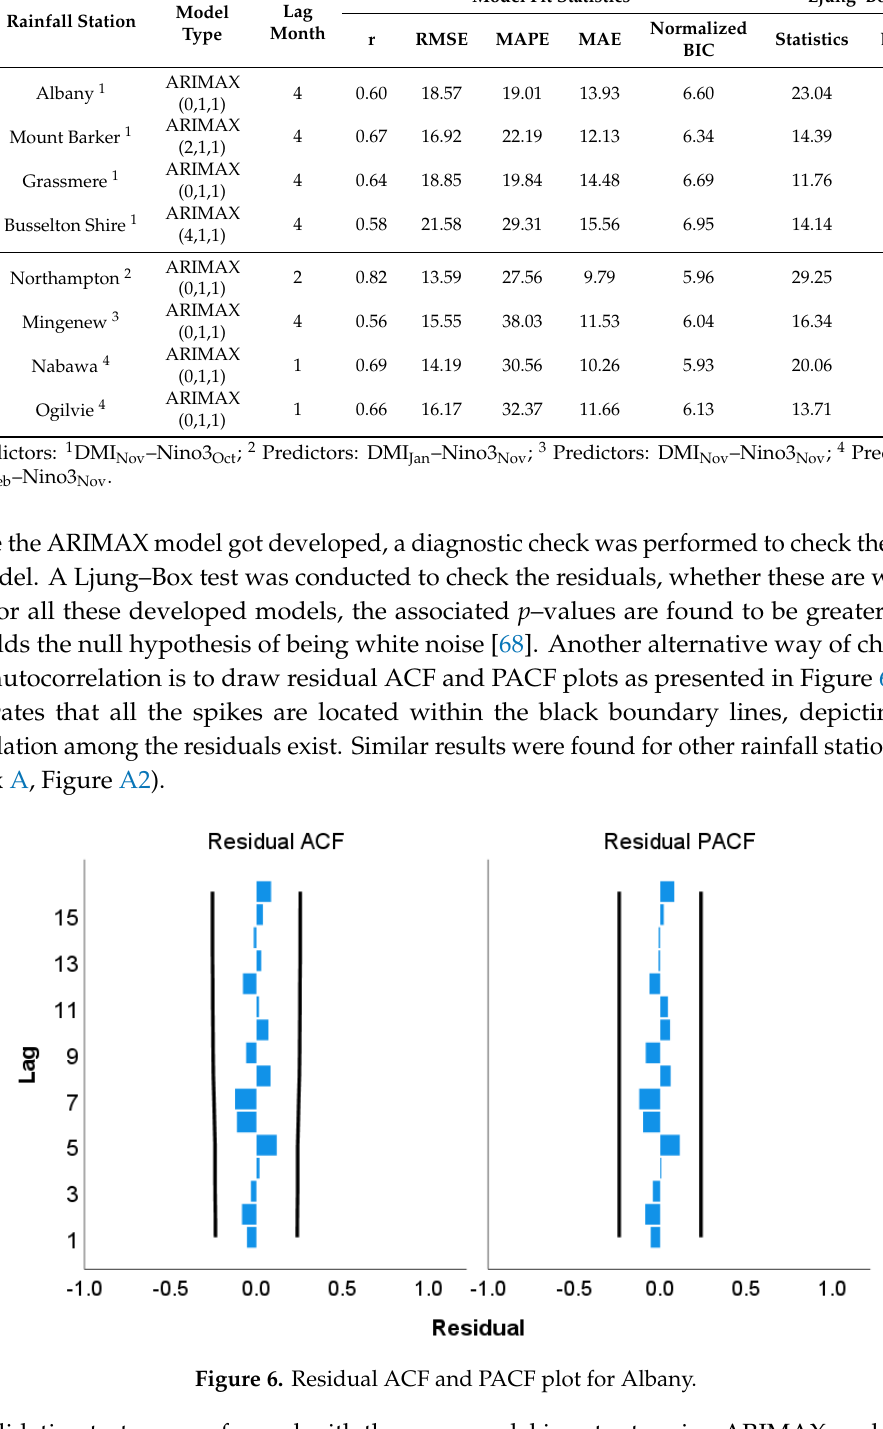
Table 6. Model description of the selected ARIMAX models in the calibration period.